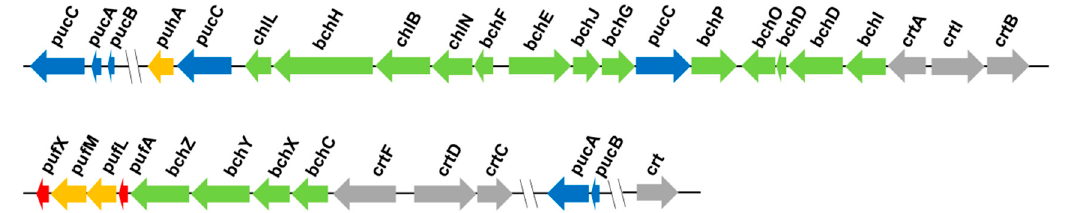
Figure 2. The photosynthetic gene cluster in strain EBL0706. Genes with different colors represent different functions (dark blue, pucABC , encoding LH2; orange, puhA and pufML , encoding RC; green, bchCDEFGHIJXYZ and chlBLN , encoding bacterial chlorophyll; red, pufAX , encoding LH1). The size and direction of arrows indicate the volume and direction of gene transcription. The characteristics of genes in Figure 2 were summarized in Table S6.